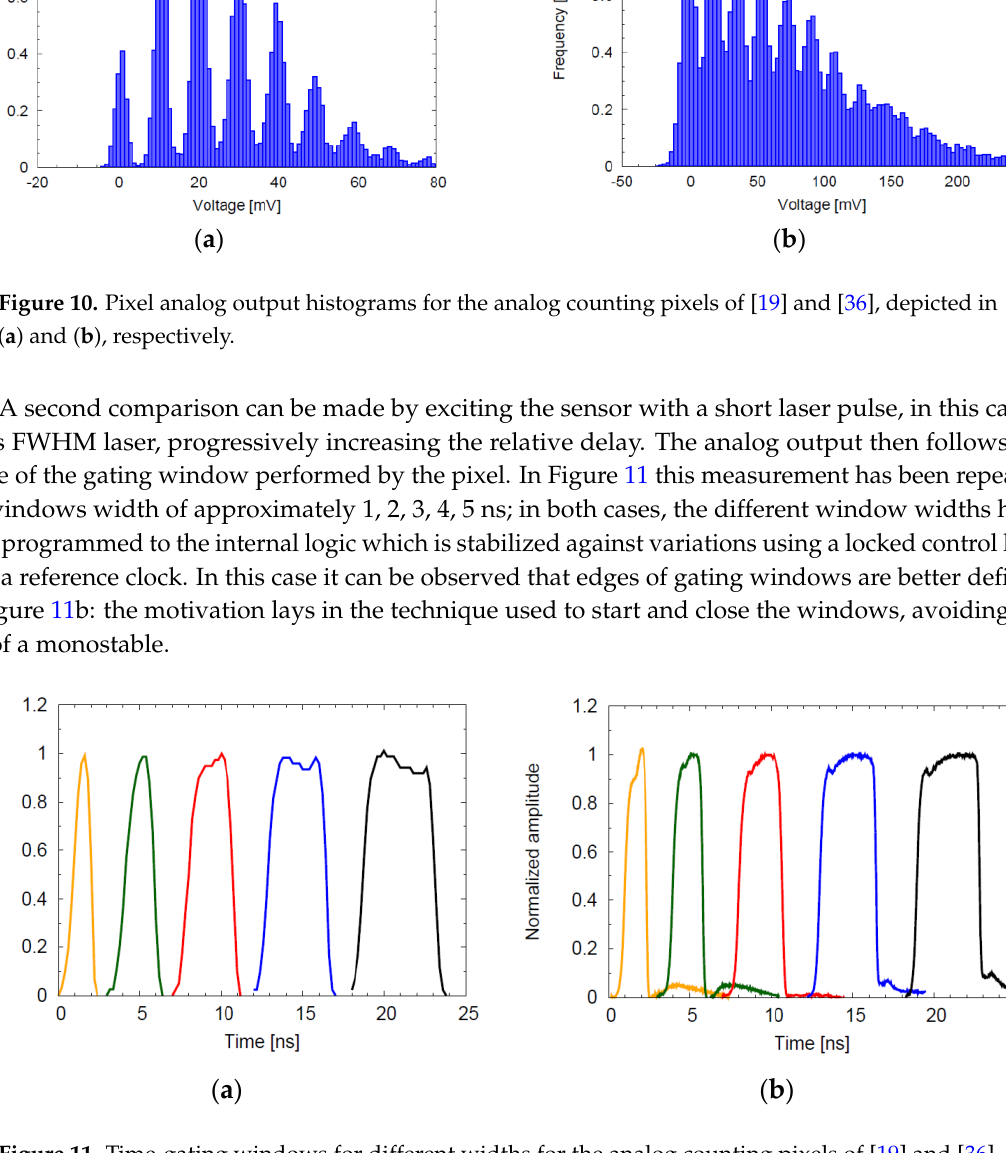
Figure 11. Time-gating windows for different widths for the analog counting pixels of [19] and [36], depicted in ( a ) and ( b ), respectively.